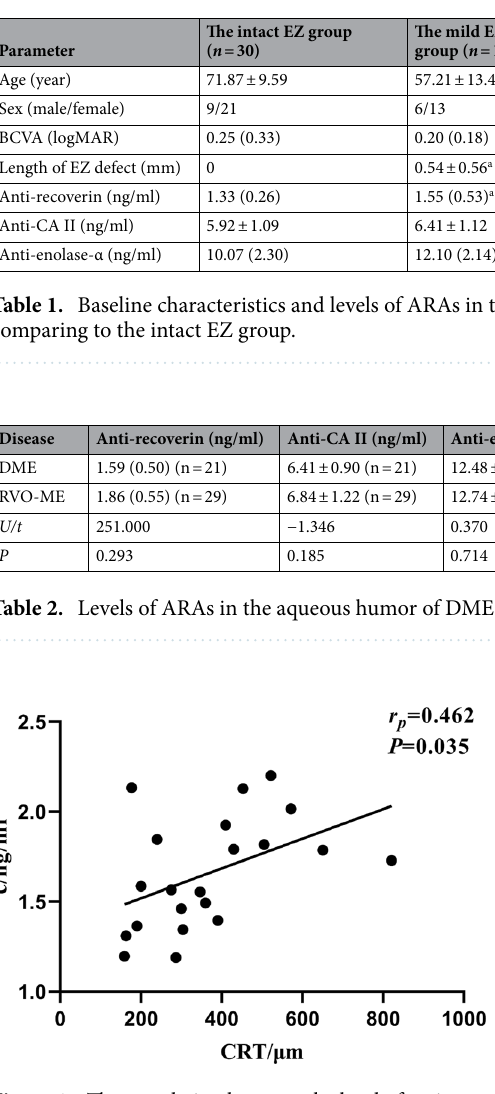
Figure 1. The correlation between the level of anti-recoverin and CRT of DME